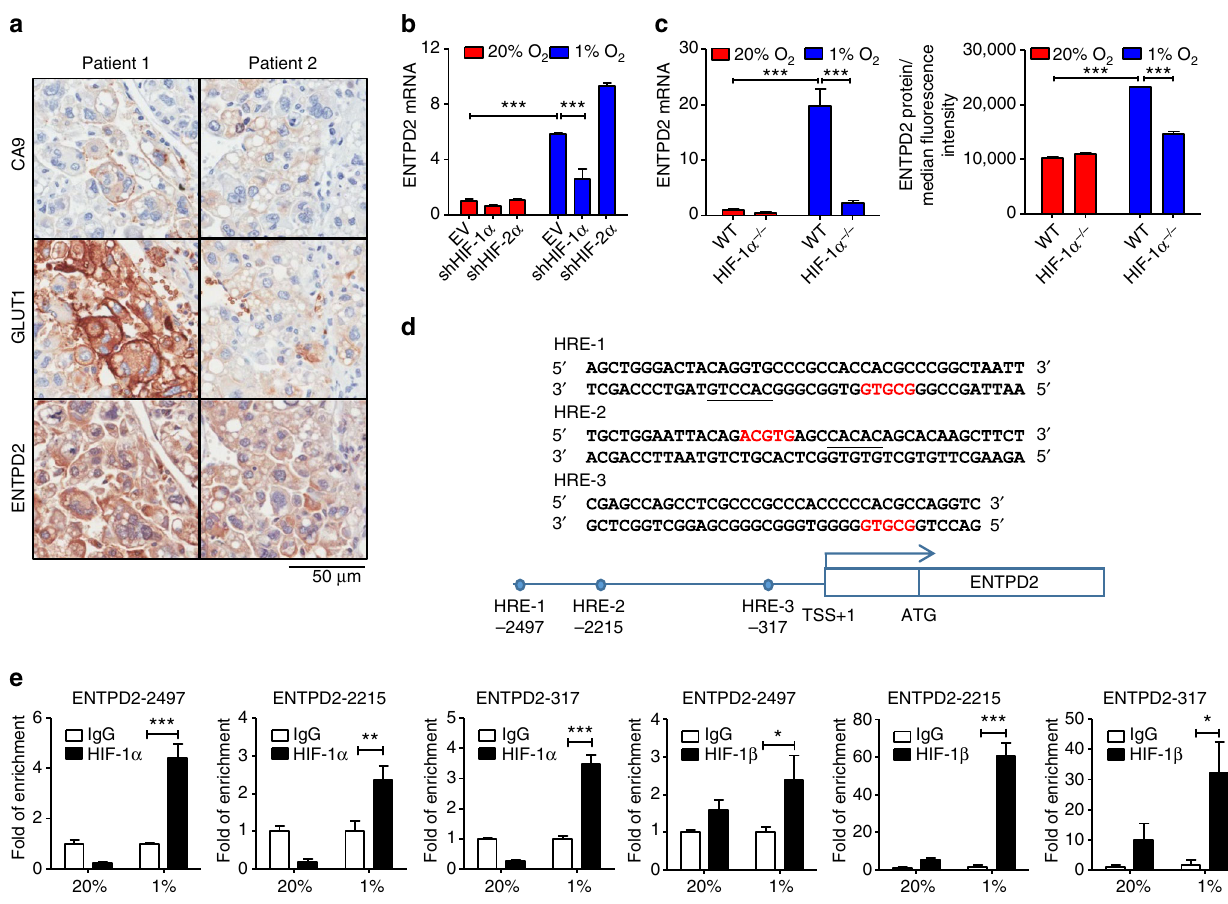
Fig. 2 ENTPD2 is a direct transcriptional target of HIF-1 α . a Representative IHC staining images of ENTPD2 and two hypoxia markers, CA9 and GLUT1, in human HCC. Overlapping staining pattern of ENTPD2, CA9, and GLUT1 was observed. b ENTPD2 mRNA expression in MHCC97L-EV, -shHIF-1 α , and shHIF-2 α clones. Cells were exposed to 20 and 1% O 2 for 24 h and ENTPD2 mRNA expression was quantitated by qRT-PCR. Values were normalized to 20% O 2 EV or WT ( n = 3). c ENTPD2 mRNA ( left ) and protein ( right ) expression in MHCC97L- HIF-1 α -WT (parental) and HIF-1 α -knockout (HIF-1 α − / − ) clones. Cells were exposed to 20 and 1% O 2 for 24 h. The mRNA and protein expressions of ENTPD2 were quantitated by qRT-PCR and fl ow cytometry, respectively. All values were normalized to 20% O 2 WT ( n = 3). d Three putative hypoxia-responsive elements (HREs), HIF binding consensus sequence, 5 ′ -A/GCGTG-3 ′ in the promoter region of ENTPD2 were located by in silico analysis. e ChIP assay was performed in MHCC97L cells exposed to 20 and 1% O 2 with IgG, HIF-1 α , and HIF-1 β antibodies. Fold of enrichment was normalized to the according IgG controls ( n = 3). Data are presented as mean ± s.d. (Student ’ s t -test, *** P <